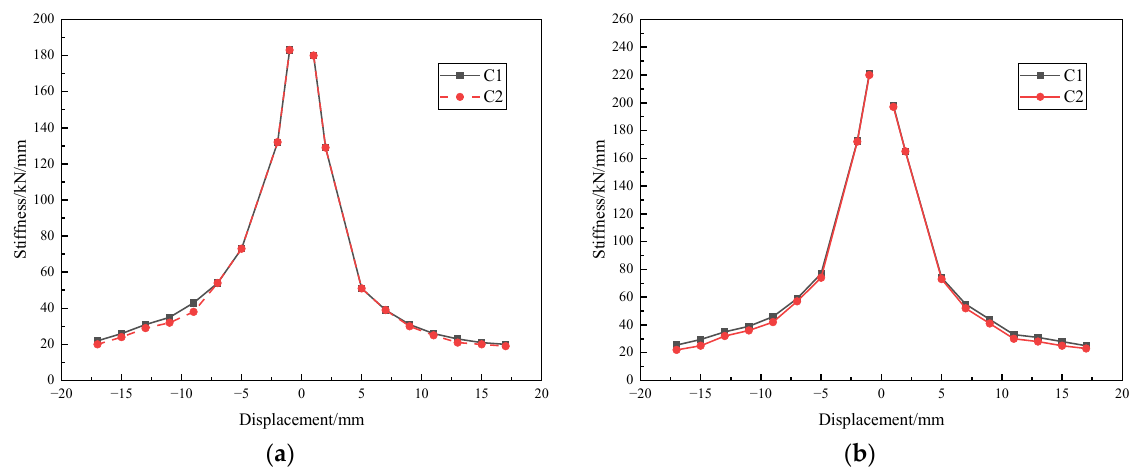
Figure 12. Stiffness degradation curves of the specimens: ( a ) S1; ( b ) S2.